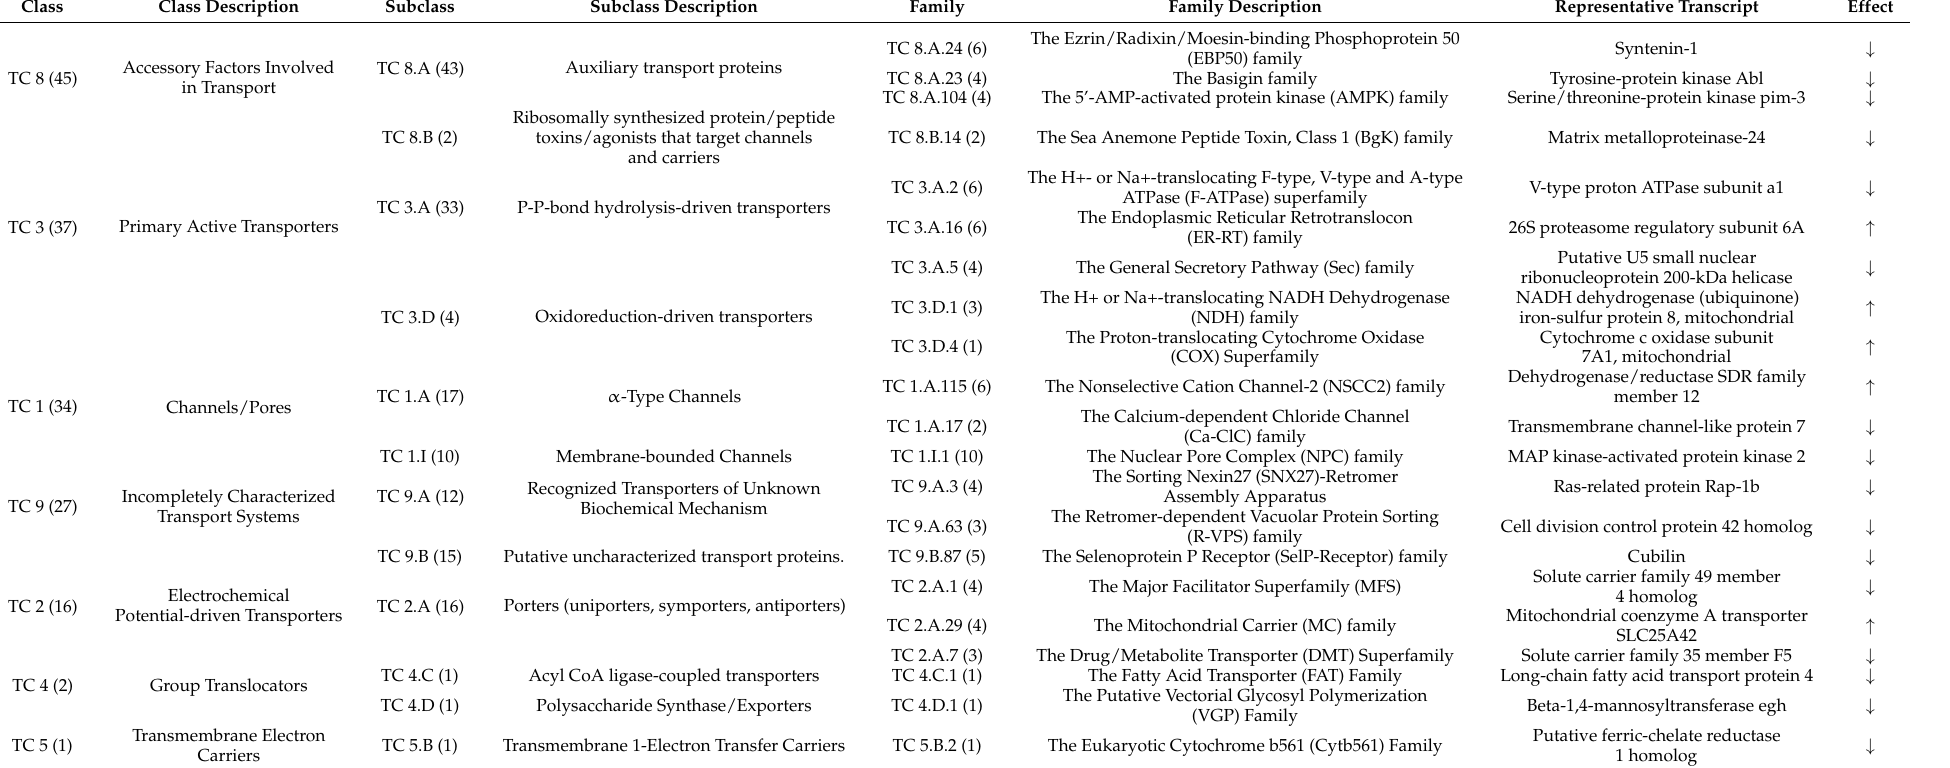
Table 5. List of the most abundant transporter classes, including their representative subclasses and families. Numbers in parenthesis indicate the total number of differentially expressed transcripts assigned to that specific class, subclass, and family. Direction of the arrow represents whether the representative transcript is downregulated ( ↓ ) or upregulated ( ↑